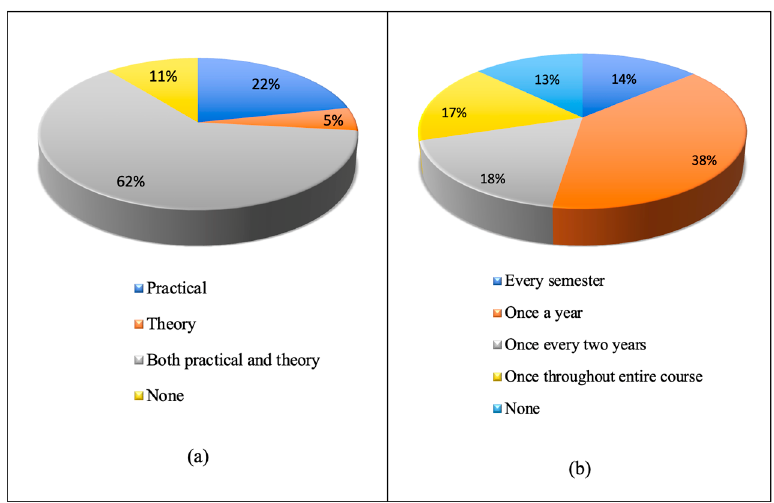
Figure 2. Pie charts showing students’ perception of ( a ) the form of DRR education that needs to be